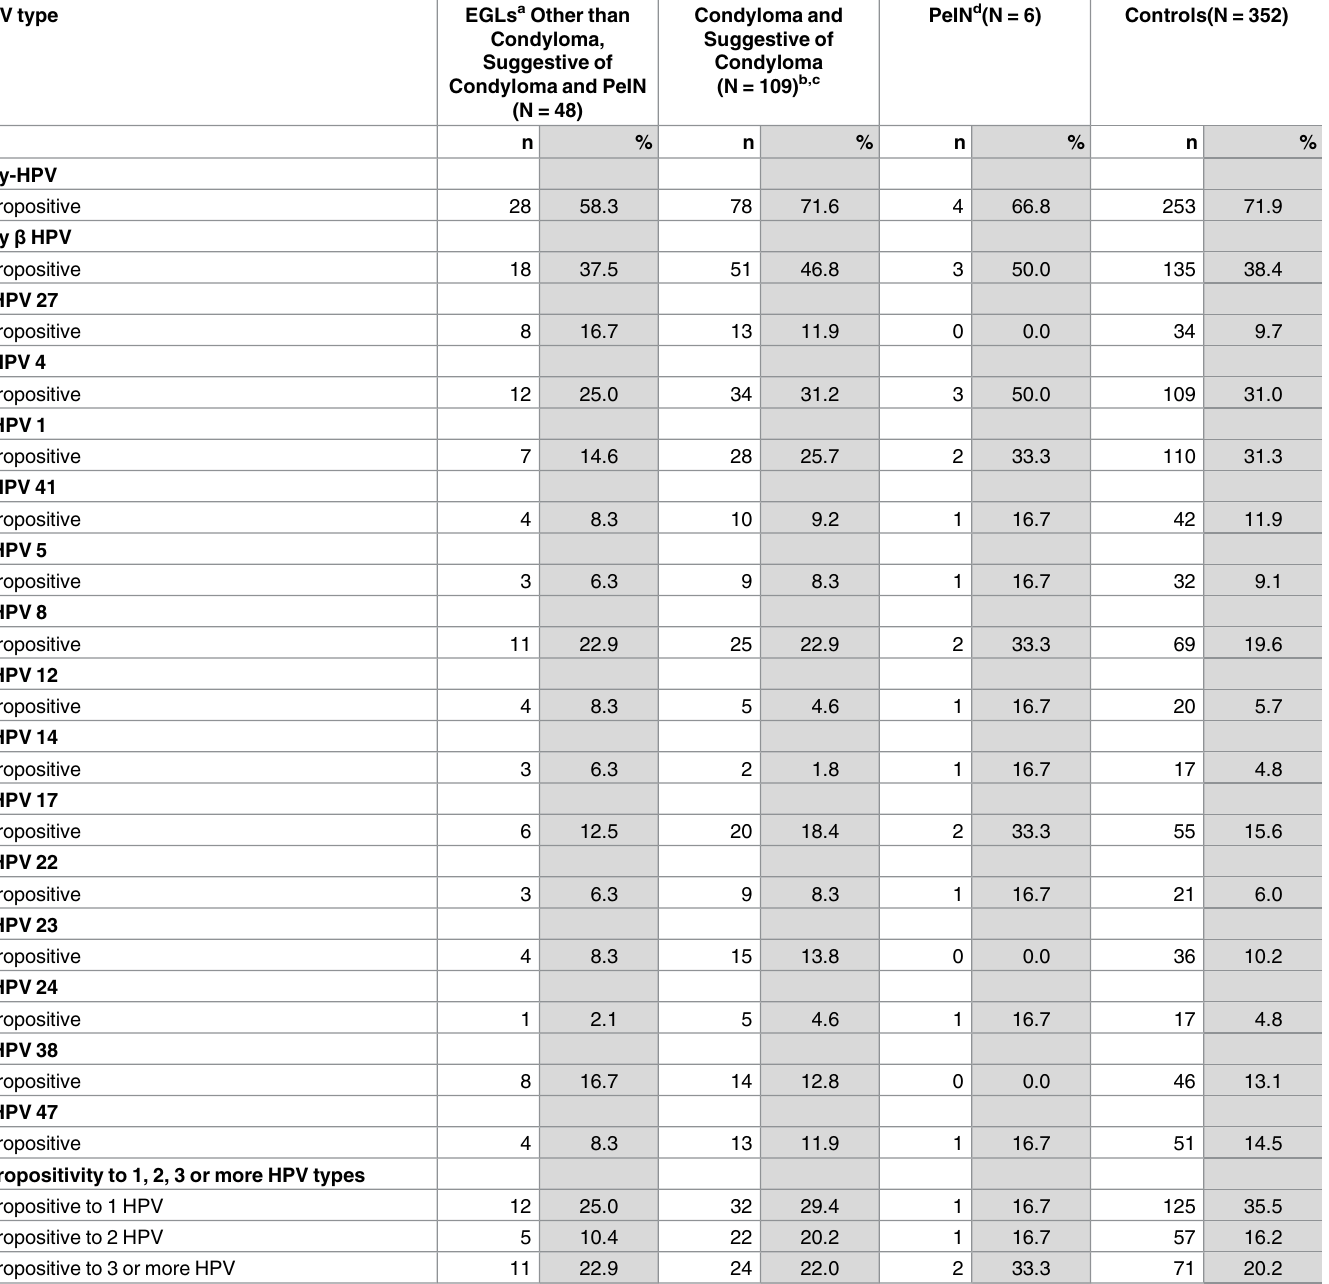
Table 2. Grouped and type-specific cutaneous HPV seropositivity by case-control status.